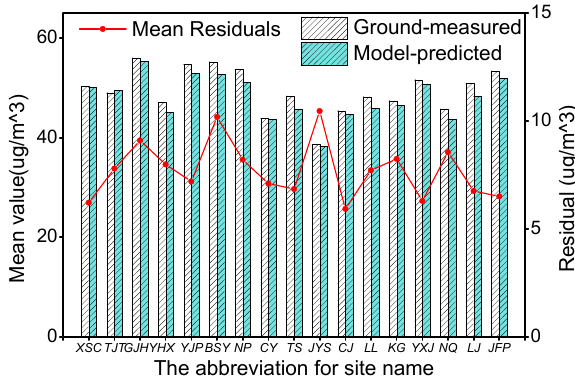
Figure 7. The mean and residuals by observing and fitting PM 2.5 at each station.